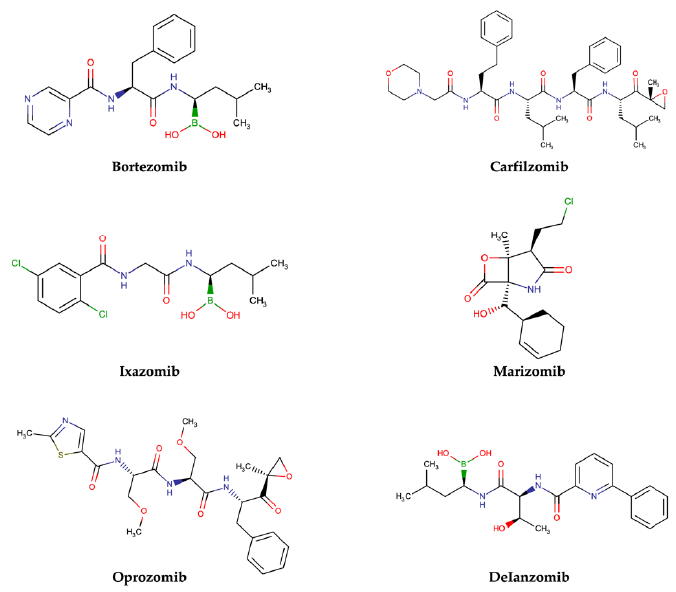
Figure 4. Two-dimensional structures of approved and investigational PIs. Marizomib